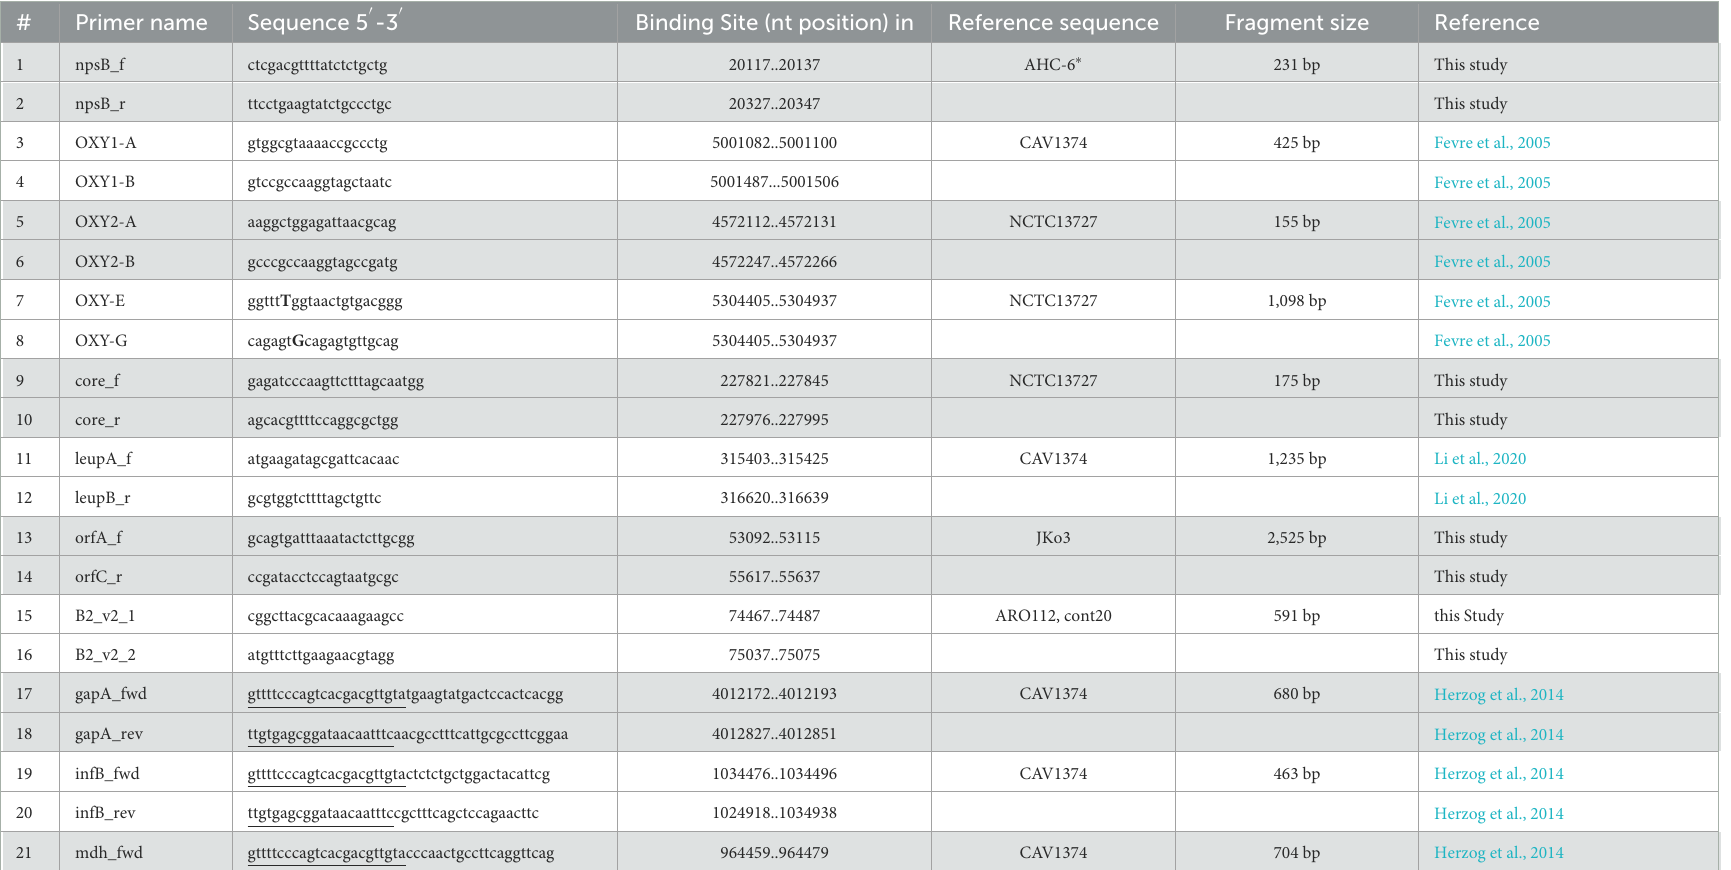
TABLE 1 Oligonucleotides used in PCR-screening and